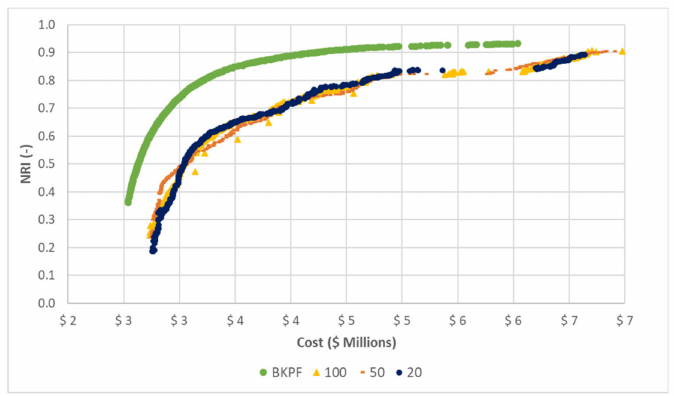
Figure 1. Comparison between tested values for the mutation distribution index after 500 generations in Modena. BKPF = Best-Known Pareto Front; NRI = network resilience